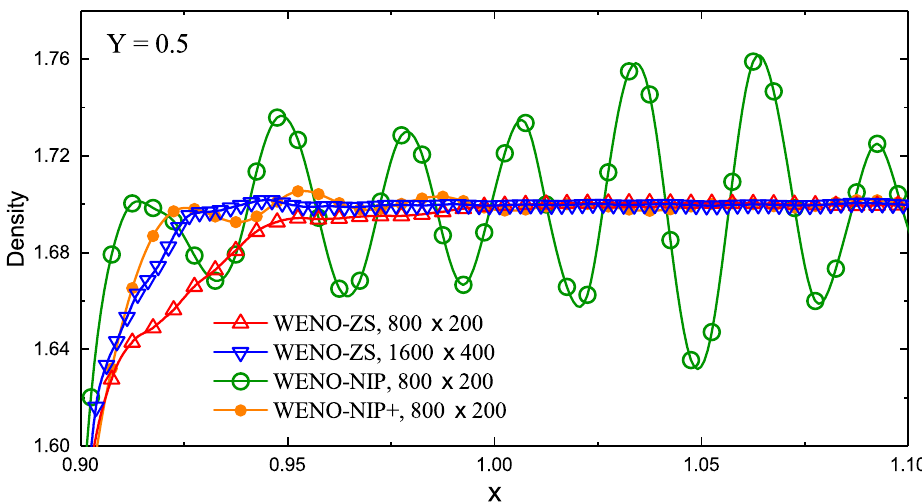
Figure 25. The cross-sectional slices of density plot of WENO-JS, WENO-Z, WENO-NIP, and WENO- NIP+ along the plane y = 0.5, where x ∈ [ 0.9,1.1 ]